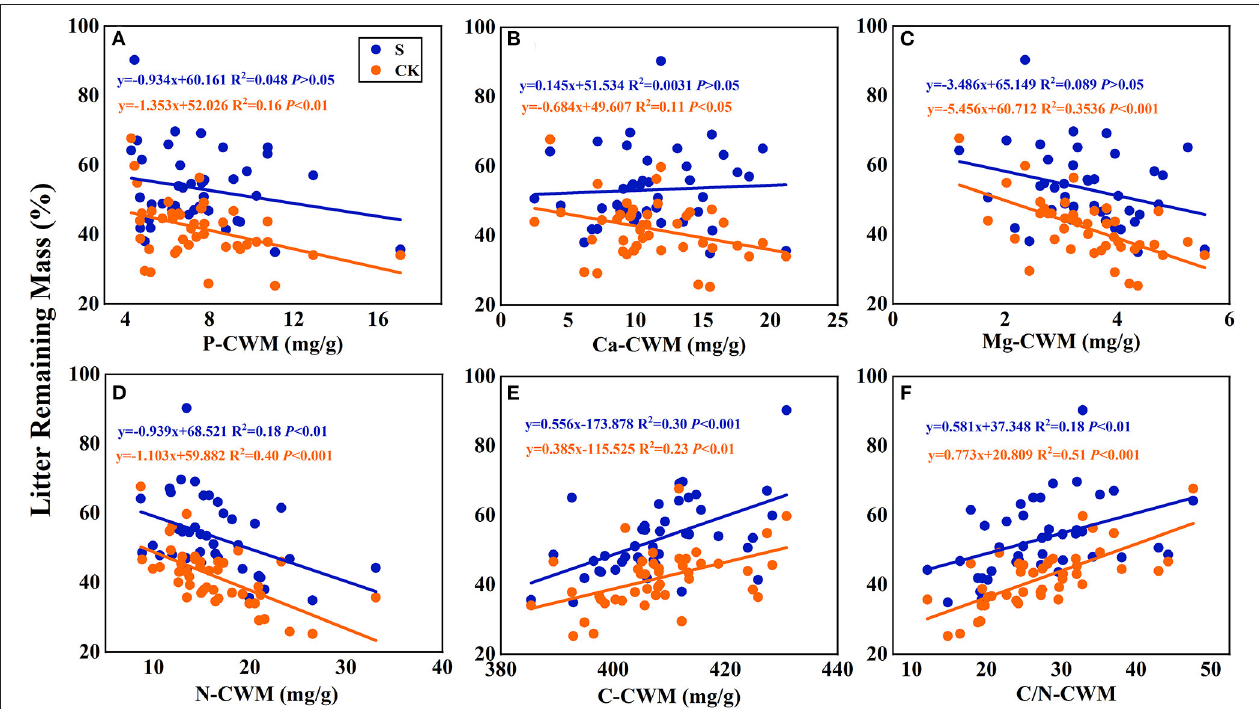
FIGURE 6 | Linear regression relationships (A–F) between litter remaining mass rate and litter community weighted mean traits (CWM). S stands for litter that has been decomposed in the submergence environment, and CK stands for litter that has been decomposed in the terrestrial